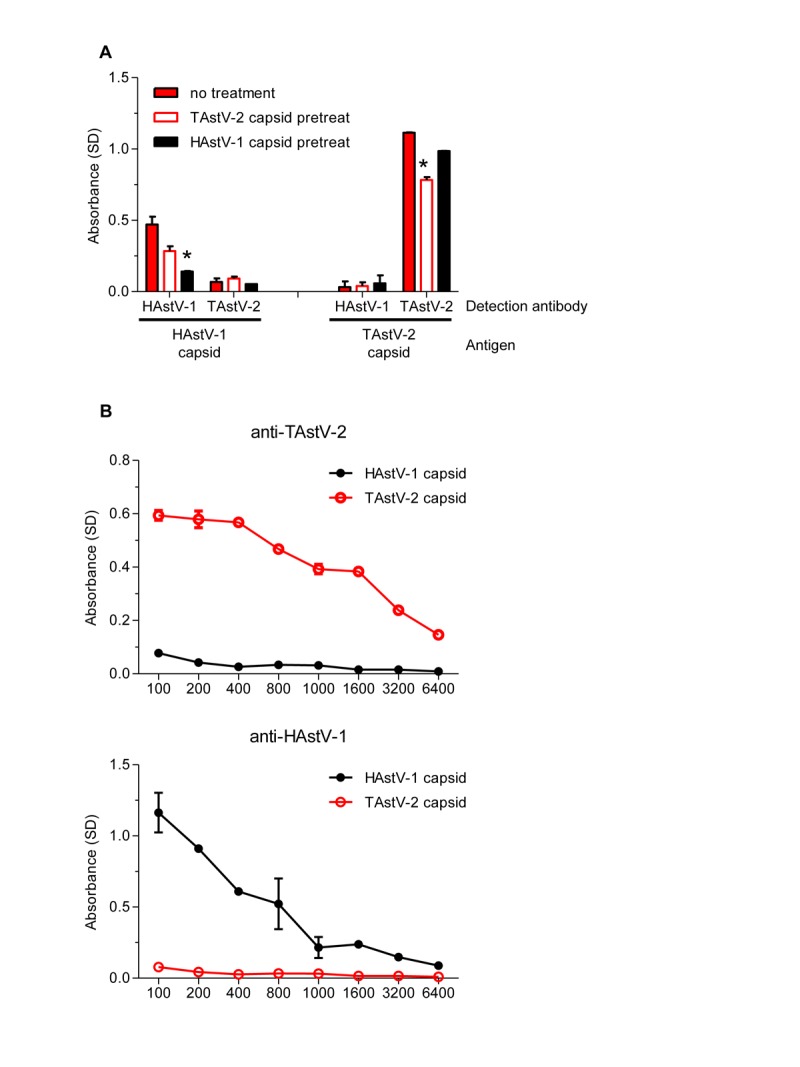
Development of a competitive astrovirus ELISA.A) Rabbit anti-HAstV-1 or TAstV-2 polyclonal antibodies were pre-incubated with PBS (no treatment) or purified recombinant HAstV-1 or TAstV-2 capsid proteins then tested for binding to bound HAstV-1 or TAstV-2 capsid protein by ELISA. *p<0.05. B) Specificity of the rabbit polyclonal antibodies. Samples were run in at least duplicate and data are shown as mean values. Error bars indicate SD.